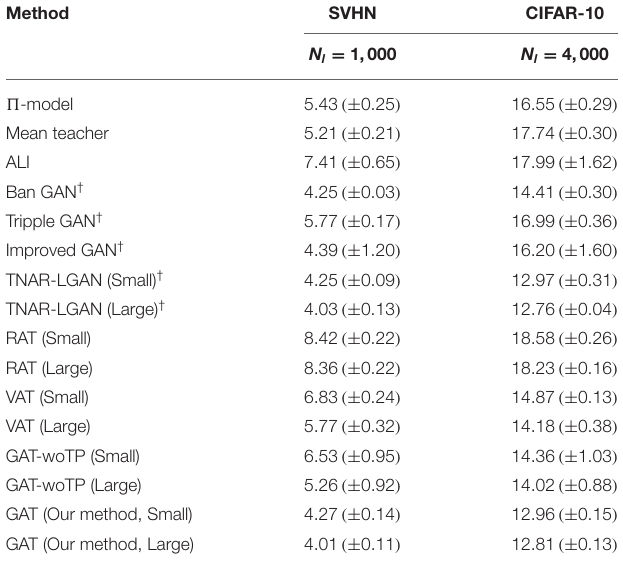
TABLE 3 | Test error rates (%) of semi-supervised learning methods on SVHN and CIFAR-10